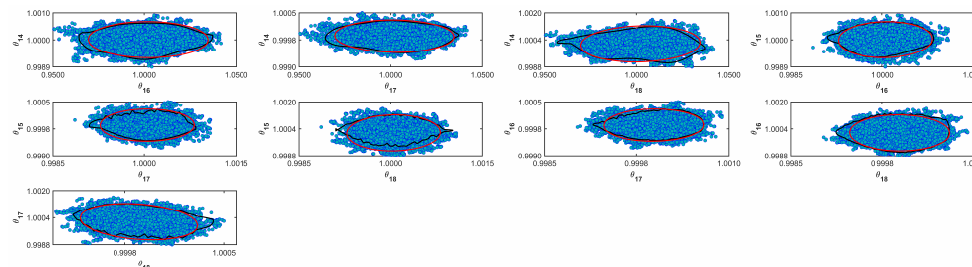
Figure A10. Coverage regions of parameters 10: (—) Gaussian region; (—) Possolo [33]